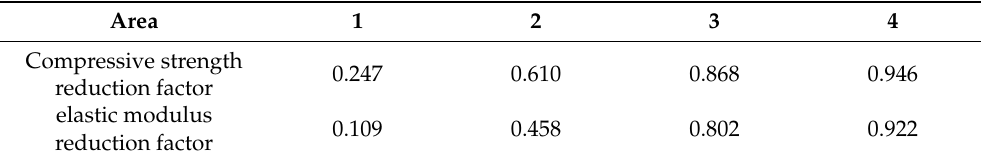
Table 3. Elastic modulus reduction coefficient of mudstone in disturbed damage